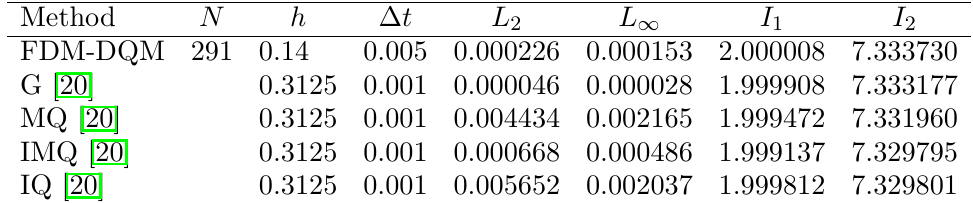
Table 4. L 2 and L ∞ error norms and invariants of single soliton: amp. = 1 , t = 2 . 5.